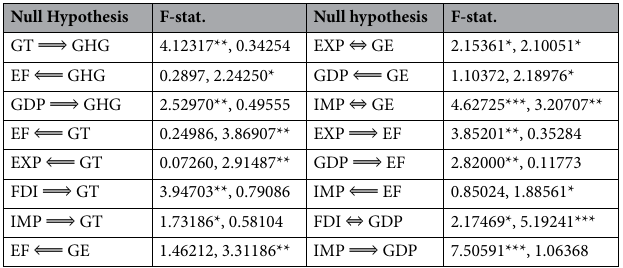
Null Hypothesis F-stat. Null hypothesis F-stat.